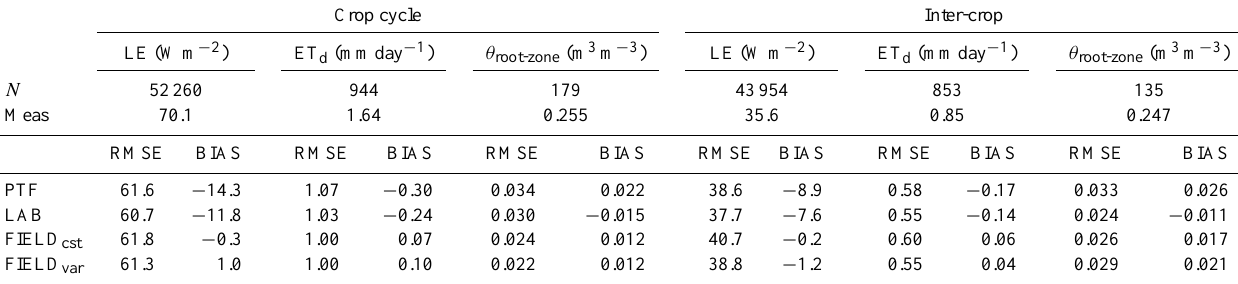
Table 6. Performances of simulated latent heat flux (LE), daily daytime evapotranspiration (ET d ) and root-zone soil moisture ( θ root-zone ) computed over the 20 November 2003–18 December 2012 period for which direct measurements of LE were available. ET d was computed when 90% of daytime measurements were valid for each day. PTF, LAB, FIELD cst and FIELD var are the simulation cases defined in Table 4. N is the number of samples used to evaluate each variable. Meas is the mean value of the measured